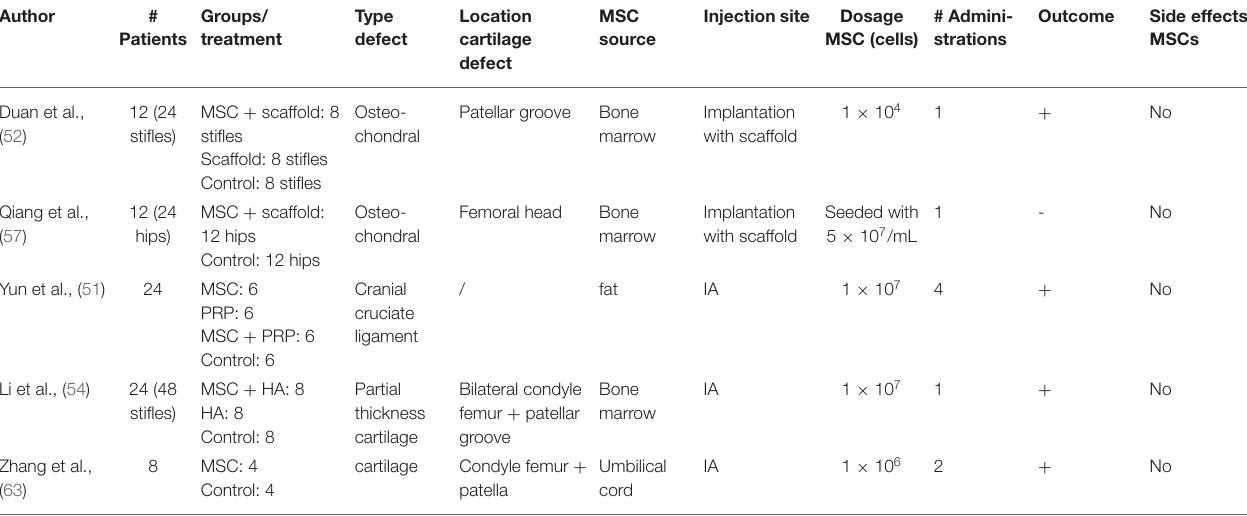
TABLE 5 | Chronologic presentation of model based studies applying allogeneic